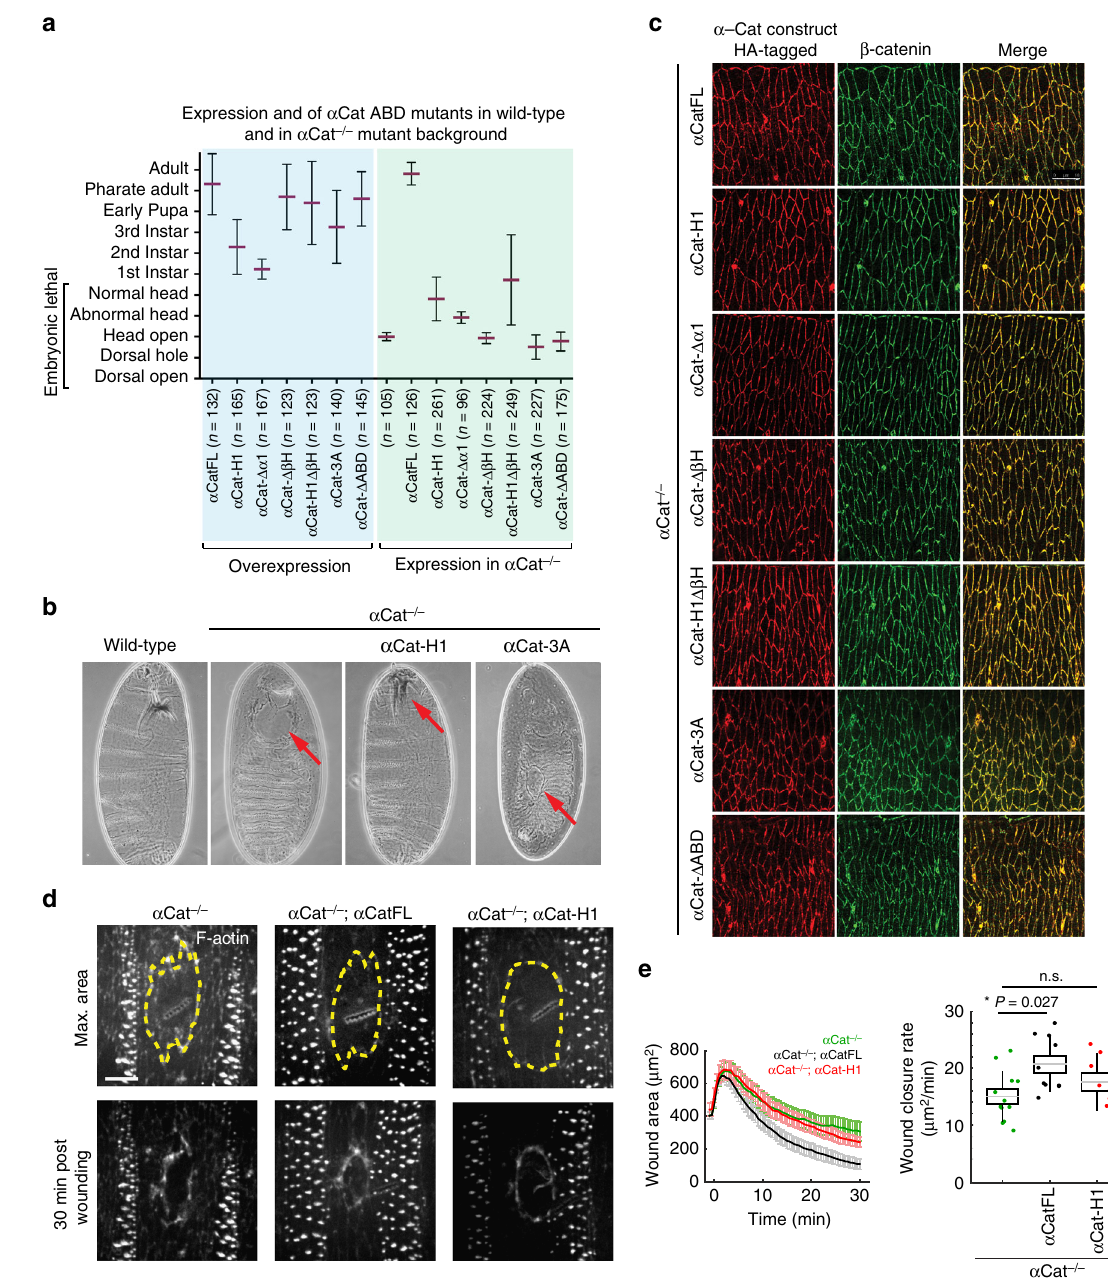
Fig. 4 α Cat ABD mutants fail to rescue α Cat function in Drosophila . a Phenotypic consequences of the overexpression of α Cat ABD mutants and rescue activity of α Cat ABD mutants expressed in α Cat − / − zygotic null mutants. Overexpression: all mutant constructs showed signi fi cantly reduced survival ( P < 0.0001) compared to α CatFL overexpression. Rescue experiments: Mutant constructs showed a signi fi cant rescue ( α CatFL, α Cat-H1, α Cat- Δα 1, α Cat- H1 Δβ H [ P < 0.0001]) or enhancement ( α Cat-3A [ P < 0.0001], α Cat- Δ ABD [ P = 0.0071]) of the α Cat − / − zygotic mutant phenotype. Expression of α Cat- Δβ H did not signi fi cantly modify the α Cat − / − mutant phenotype. Data are presented as mean ± SD. b Cuticles of wild-type embryo, of α Cat − / − mutant showing failure in head morphogenesis ( ‘ head open ’ ; arrow), of α Cat − / − mutant expressing α Cat-H1 showing a defective head skeleton ( ‘ abnormal head ’ ; arrow), and of α Cat − / − mutant expressing α Cat-3A showing dorsal hole (arrow) in addition to an open head. c HA-tagged α Cat variants were expressed with Act5c-Gal4 da-Gal4 in the epidermis of Drosophila embryos mutant for α -Cat ( α Cat − / − ) at stage 15. AJs marked by β -catenin. d Epidermal wounds in α Cat − / − , α Cat − / − mutant expressing α CatFL, and α Cat − / − mutant expressing α Cat-H1. F-actin was labeled with GFP::UtrophinABD. Top panels show time of maximum wound area (yellow lines outline the wounds) and bottom panels show epidermis 30 min after wounding. Anterior left, dorsal up. Scale bar, 10 μ m. e Wound area over time (left) and wound closure rate (right) for α Cat − / − (red, n = 12 wounds), α Cat − / − mutants expressing α CatFL (cyan, n = 10 wounds), and α Cat − / − mutants expressing α Cat-H1 (green, n = 10 wounds). α CatFL, α Cat − / − embryos repaired damage to their epidermis signi fi cantly faster than α Cat − / − embryos ( P = 0.027), whereas α Cat-H1 α Cat − / − embryos did not show a signi fi cant difference to α Cat − / − embryos. The box plot shows the mean (gray line), SEM (box), and SD (black